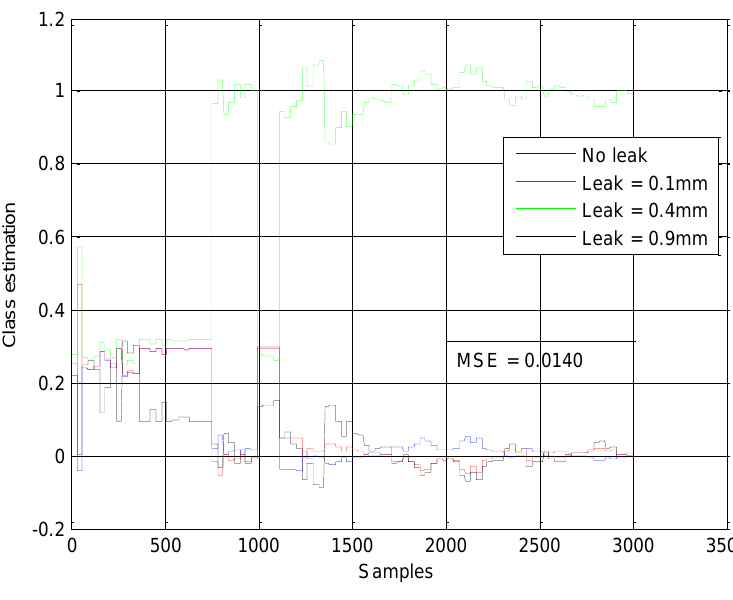
Figure 12. Leak Characterization in “Medium Leakage”